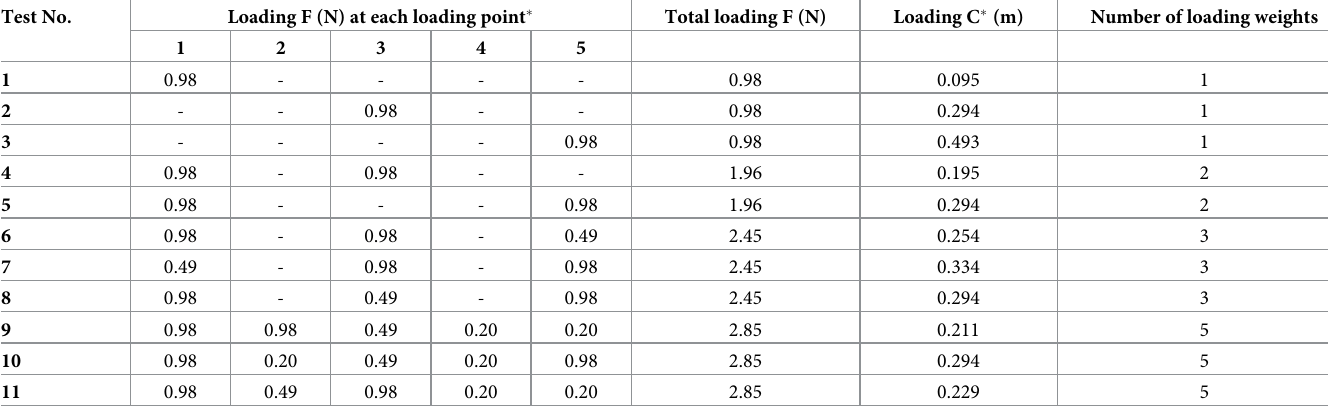
Table 1. Distributed load